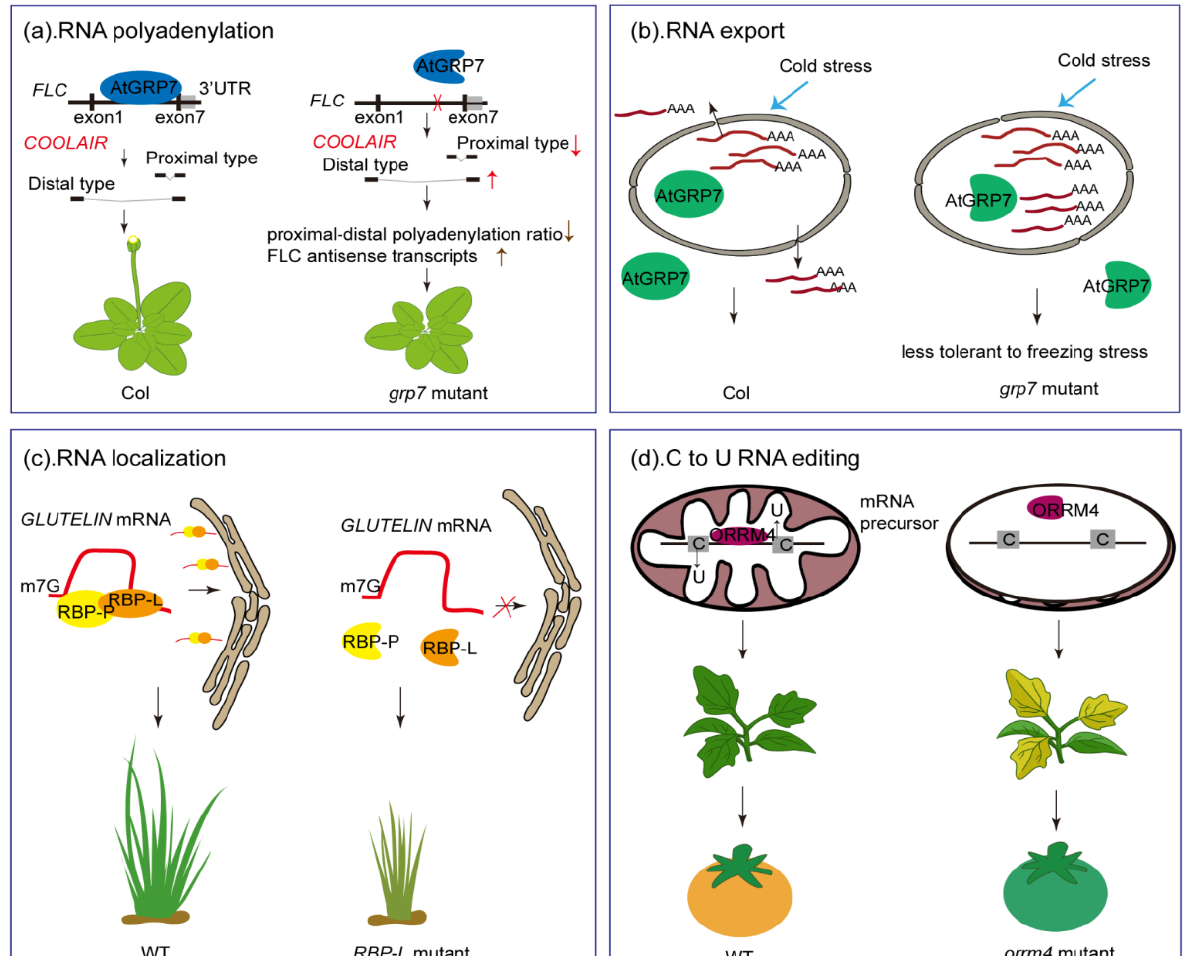
Figure 3. Cellular functions of diverse GR-RBPs involved in RNA metabolism during plant growth, development and stress responses. ( a ) AtGRP7 affects the polyadenylation site usage of COOLAIR transcripts, leading to an altered ratio of proximally–distally spliced variants. Loss of AtGRP7 function leads to increased abundance of FLC antisense transcripts and a reduced proximal–distal polyadenylation ratio, resulting in late flowering compared with the wild type. ( b ) AtGRP7 is located in the nucleus and cytoplasm and is involved in mRNA export from the nucleus to the cytoplasm under cold stress conditions. In grp7 mutants, the export of mRNA is impaired, leading to its accumulation in the nucleus, while mRNAs transcribed in the nucleus are efficiently exported to the cytoplasm in wild-type plants subjected to cold stress. ( c ) An insertional allele in rice, RBP-L , causes growth defects due to the loss of RBP and the consequent mislocalization of GLUTELIN target RNA. ( d ) Knocking out the mitochondrial RNA editing factor ORRM4 in tomato causes defective mitochondrial editing, leading to yellowish seedlings and delayed fruit ripening.